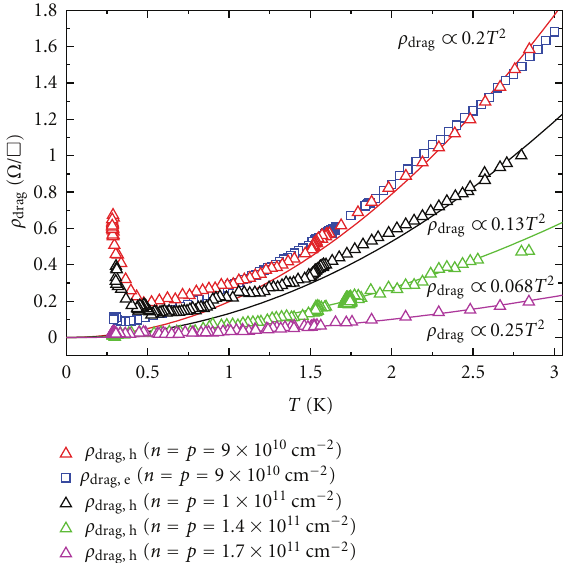
Figure 9: Hole drag resistivity versus temperature shown for n = p = 9,10,14,17 × 10 10 cm − 2 , down to 300 mK. Electron drag is only shown for n = p = 9 × 10 10 cm − 2 for clarity. (Device: B138/C4- 1-10nm Barrier). The drag voltage was measured in two ways, by sending current through the electrons and measuring the open- circuit voltage across the holes ( ρ drag,h = V h /I e ) or by sending current through the holes and measuring the voltage across the electrons ( ρ drag,e = V e /I h ). As long as the current is low enough so that the system is in the linear response regime, thermodynamic arguments [54] predict that ρ drag,e = ρ drag,h